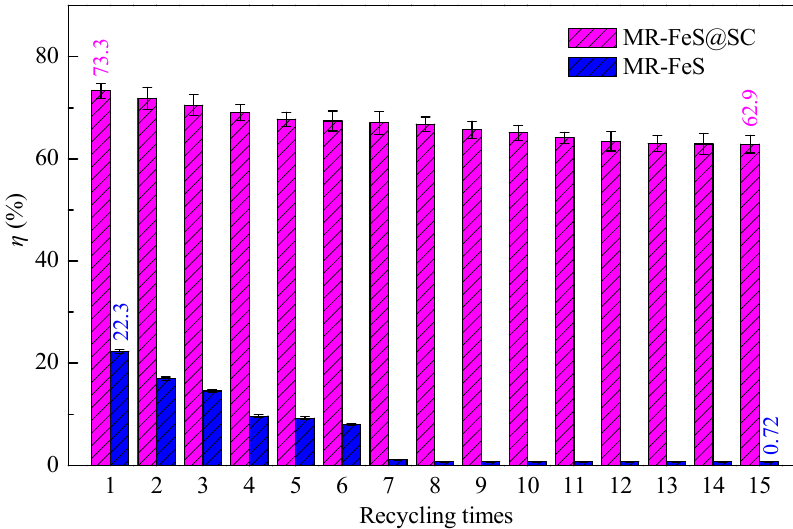
Figure 11. Removal efficiency of ST adsorbed by MR – FeS and MR – FeS@SC recycled for different times (adsorbent dosage = 0.8 g L − 1 , C 0 (ST) = 100 g L − 1 , temperature = 30 °C, pH = 7.0, and contact time = 360 min).